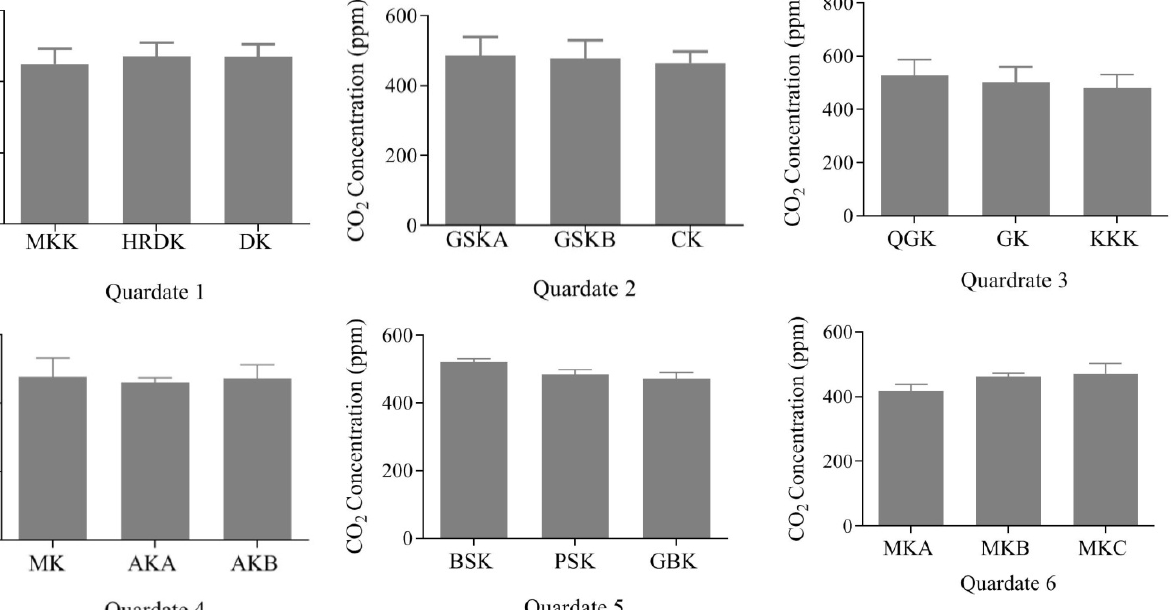
2 in the sampling